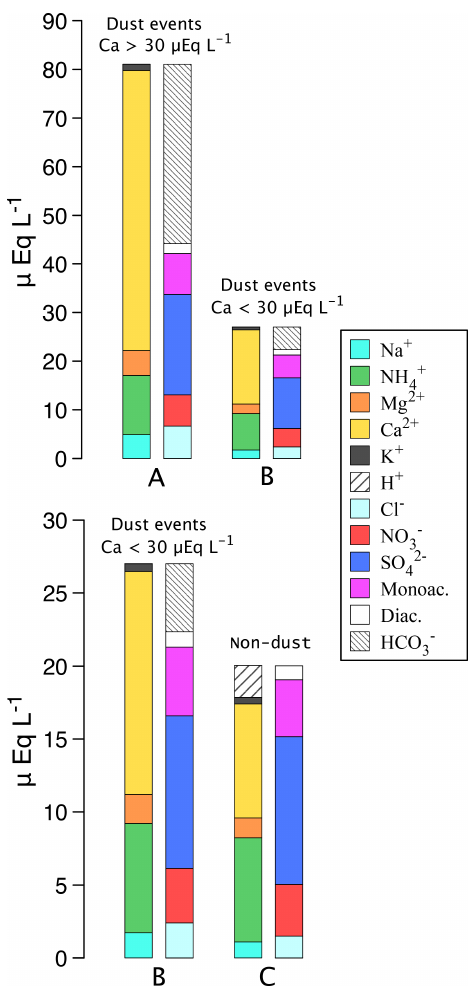
Figure 6. Mean ionic content of ELB layers deposited between 1950 and 1980.